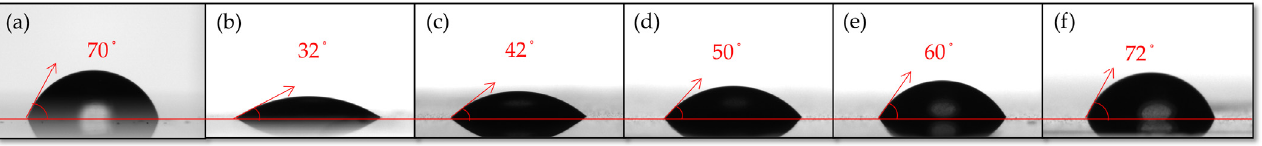
Figure 1. Water contact angle values for the PET samples after plasma treatment.